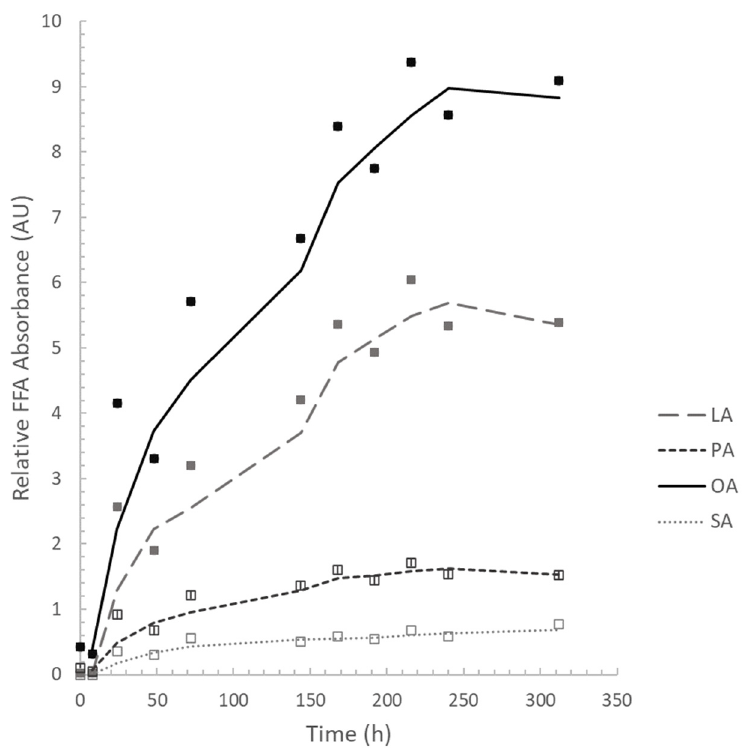
Figure 5. HPLC analysis of released FFAs from scale-up cultures. Relative absorbance of released FFAs using heptadecanoic acid as internal standard (final concentration 1 mM). LA: linoleic acid; OA: oleic acid; SA: stearic acid; PA: palmitic acid. Data represent a representative experiment (from three independent experiments) performed in a single run.